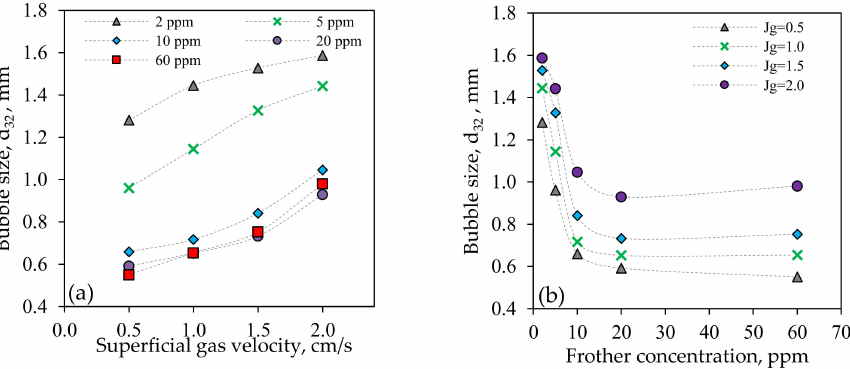
Figure 4. Bubble size as a function of ( a ) superficial gas velocity and ( b ) MIBC frother concentration.